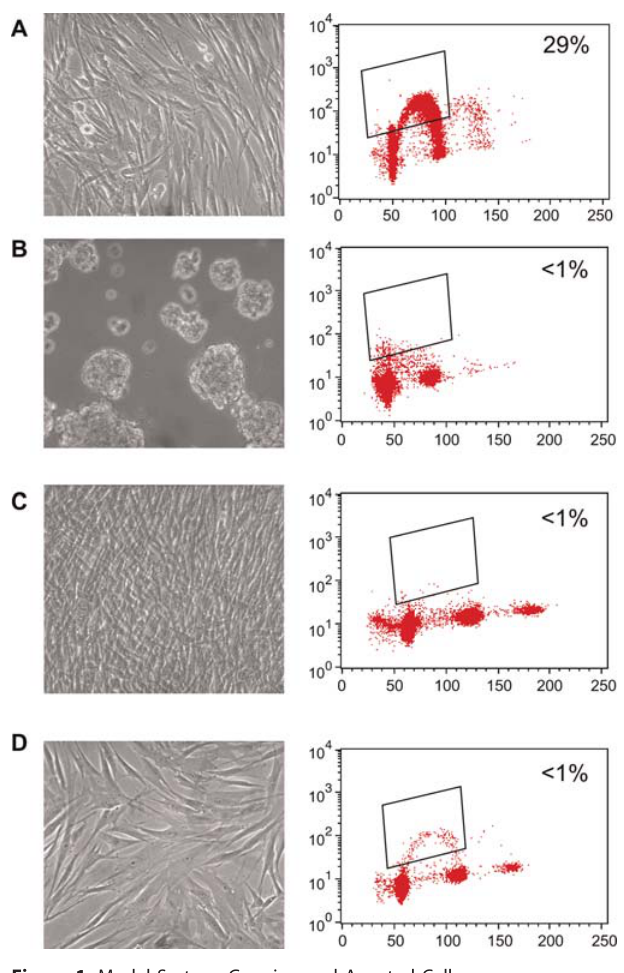
Figure 1. Model System: Growing and Arrested Cells Photographs of growing cells (A), and cells arrested overnight by loss of adhesion (B), contact inhibition (C), or mitogen withdrawal (D) are shown. Growing cells and cells that were arrested for 4 d by one of the three different arrest signals were incubated with bromodeoxyuridine (BrdU). Cell nuclei were labeled with an anti-BrdU antibody and propidium iodide, and analyzed by FACS. DNA content was plotted along the x -axis, and BrdU intensity was plotted along the y -axis. In growing cells, 28% of the nuclei incorporated BrdU during a 6-h incubation, while less than 1% of the arrested cells incorporated BrdU during the same time period. At 14 h , 10% of the cells were in S phase. 2N (G1) cells in all conditions were purified by sorting. DOI: